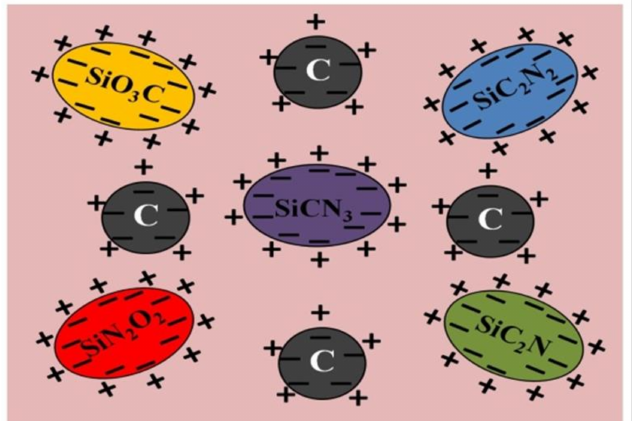
Figure 8. Schematic diagram of space charge polarization of PDC-SiCN when an alternating electro- magnetic field is